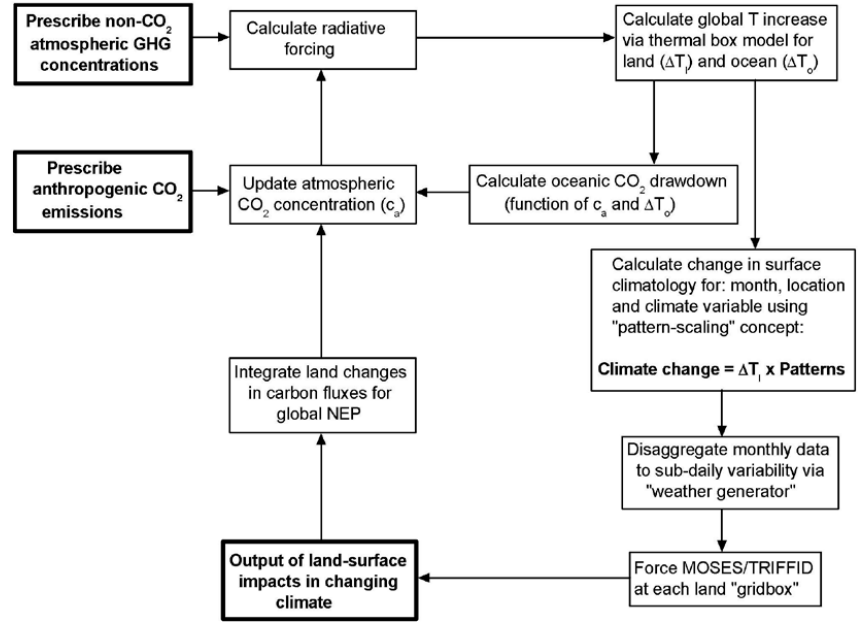
Fig. 1. A schematic of the different components forming the IMOGEN impacts tool. Abbreviations are as follow: GHG for Greenhouse Gases, T for Temperature and NEP for Net Ecosystem Production. Optionally, non-CO 2 atmospheric GHG concentrations can be prescribed. Currently IMOGEN excludes the influence on radiation of varying volcanic and non-volcanic aerosols and also varying solar constant.